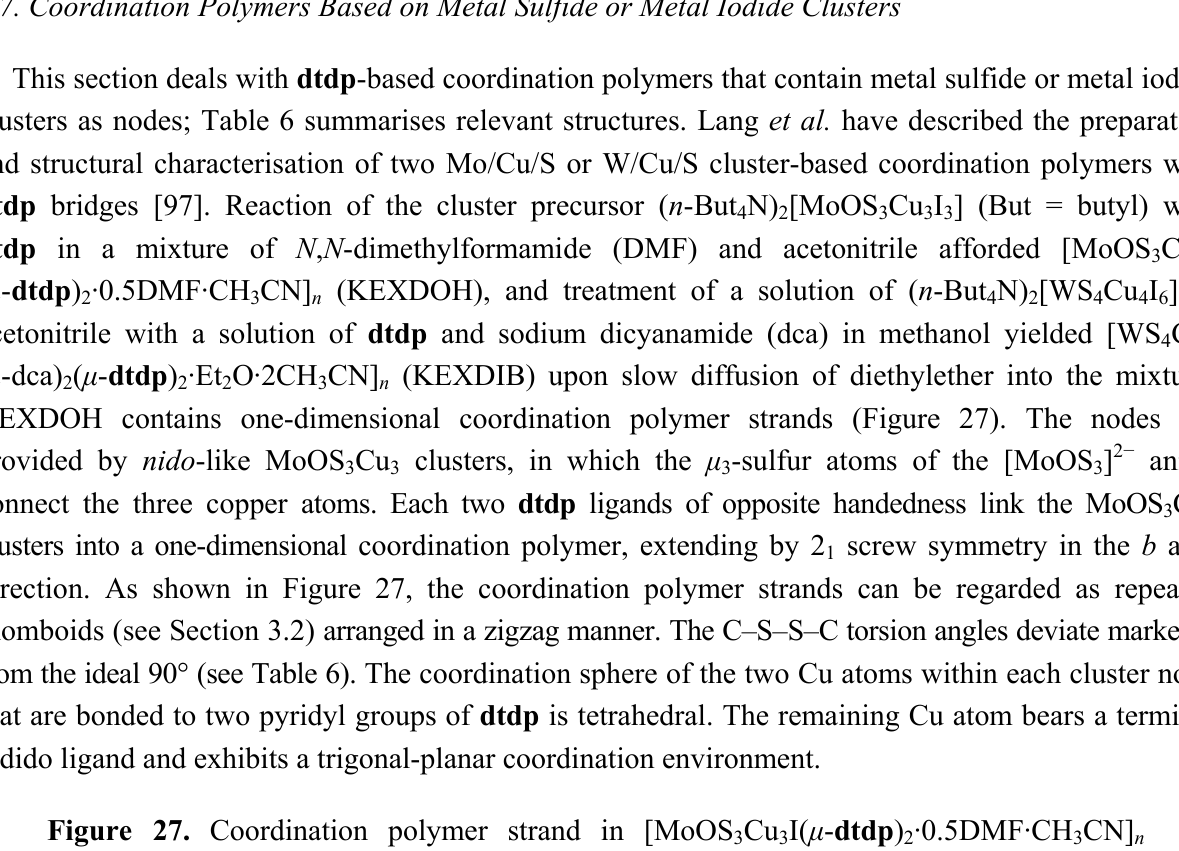
Cu I( μ - dtdp ) ·0.5DMF·CH 3 3 2 Cu clusters each joined by two dtdp ligands 3 3